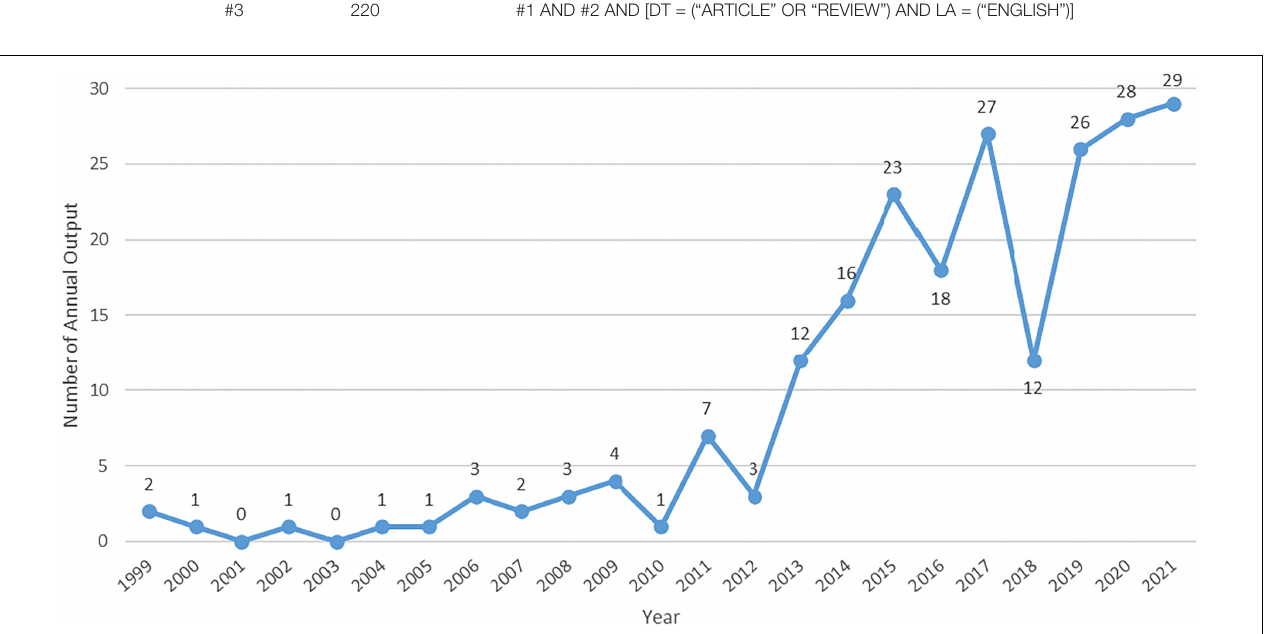
FIGURE 1 | The annual number of publications on TCE for neurodegenerative diseases between 1999 and